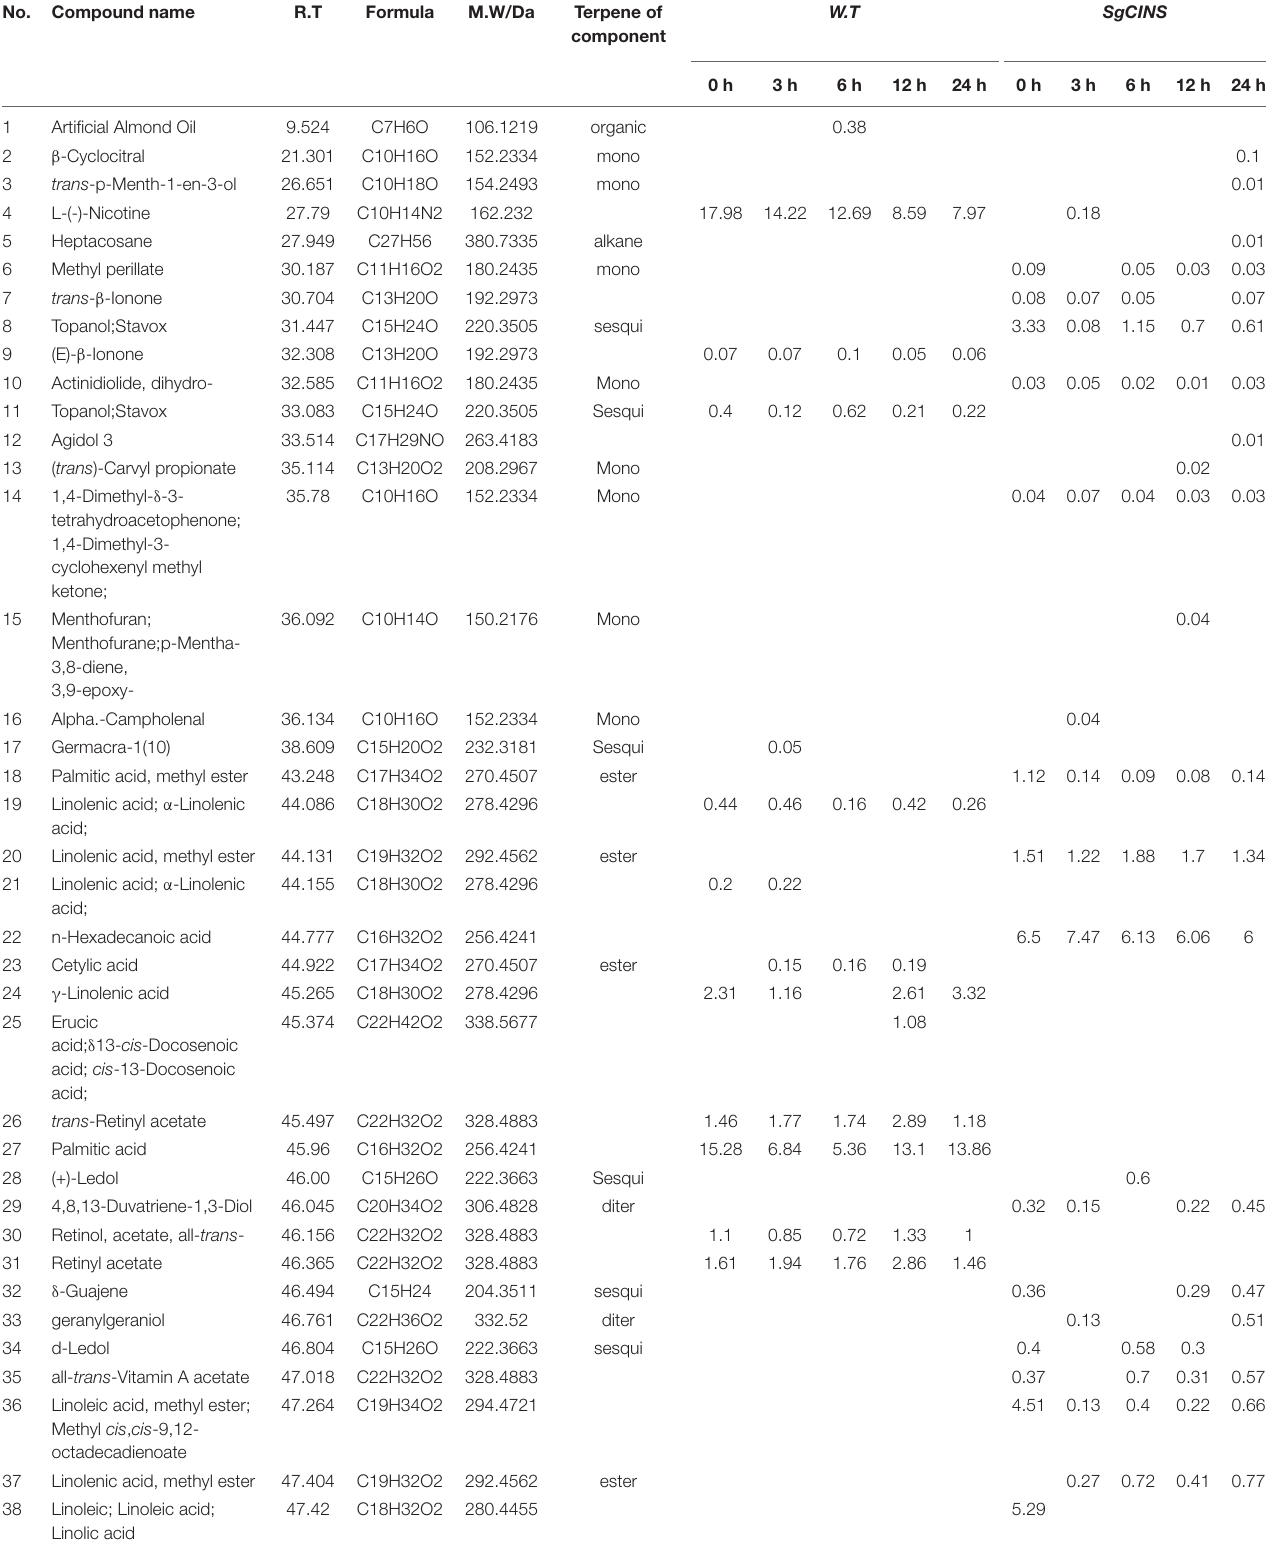
TABLE 1 | The major chemical composition and terpenes from transgenic Nicotiana tabacum leaves at different times from insect force-feeding assays. No. Compound